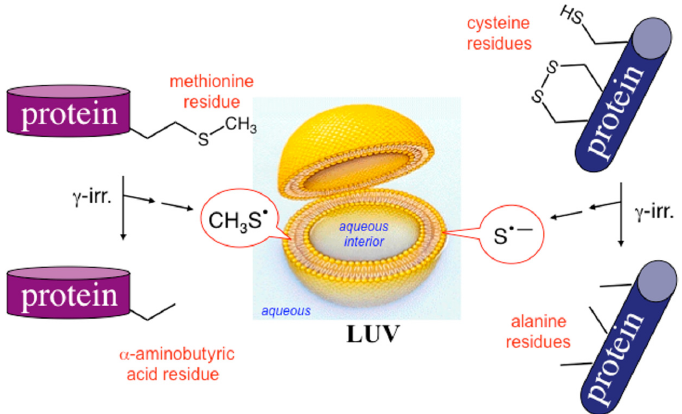
Figure 4. Tandem protein–lipid damage under reductive radical stress. Methionine and cystine residues are modified to α -aminobutyric acid and alanine/cysteine, respectively, by the attack of H • and/or e − aq . Concomitant formation of diffusible sulfur-centered radicals (CH 3 S • or S • − ) able to migrate into the lipid bilayer induces cis − trans isomerization of unsaturated fa tt y acid residues. Taken from reference [43].